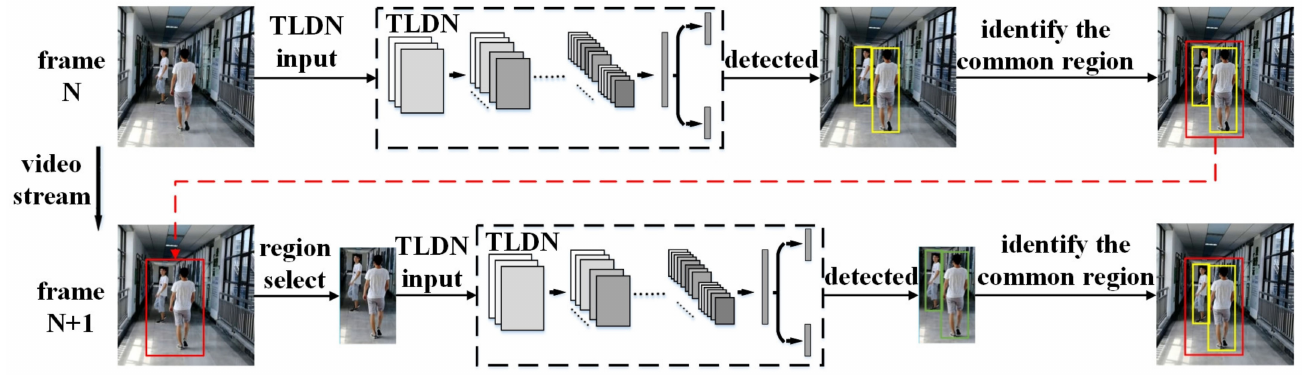
Figure 4. Proposed adaptive region focusing